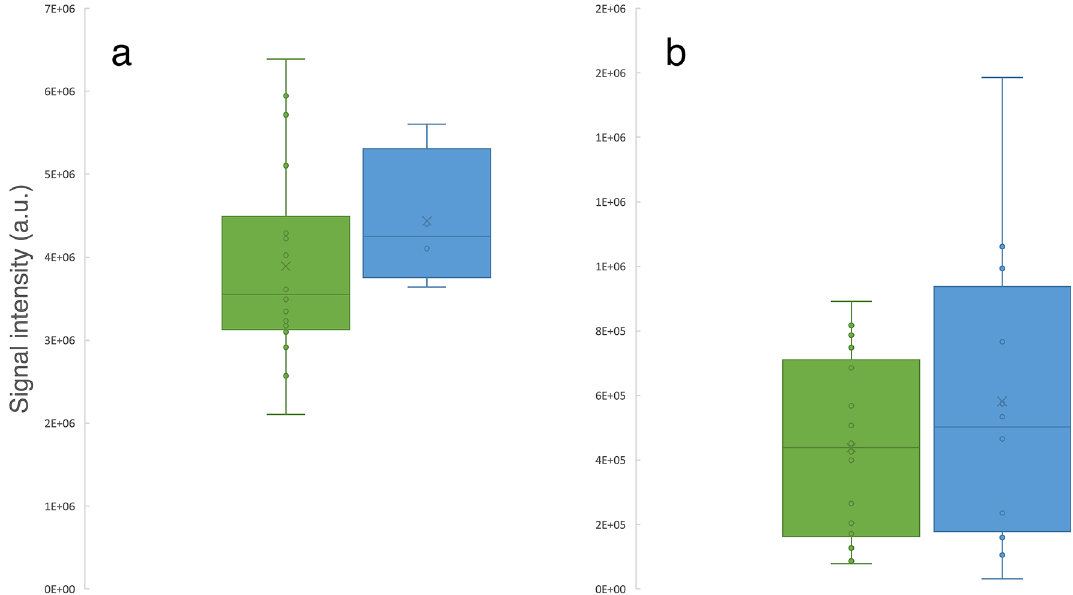
Figure 6. Boxplots representing signal intensities of significantly (p < 0.05) altered metabolites in patient groups diagnosed with short aganglionic segment (green, n = 24) and with either long aganglionic segments or total colonic aganglionosis (blue, n = 14) for 3-methyl-2cyclohexene-1-one ( a ) and 2-methyl-3-pentanon ( b